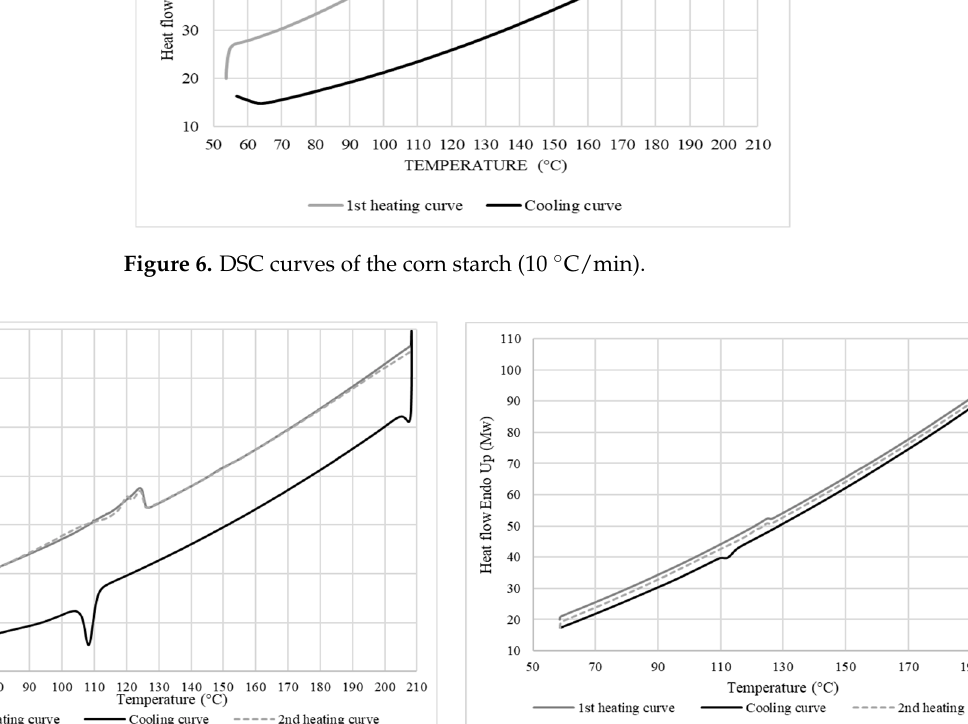
Figure 7. DSC curves of LDPE at a rate of ( a ) 10 °C/min (top) and ( b ) 2 °C/min (bottom). Table 1. LDPE parameters obtained by DSC.